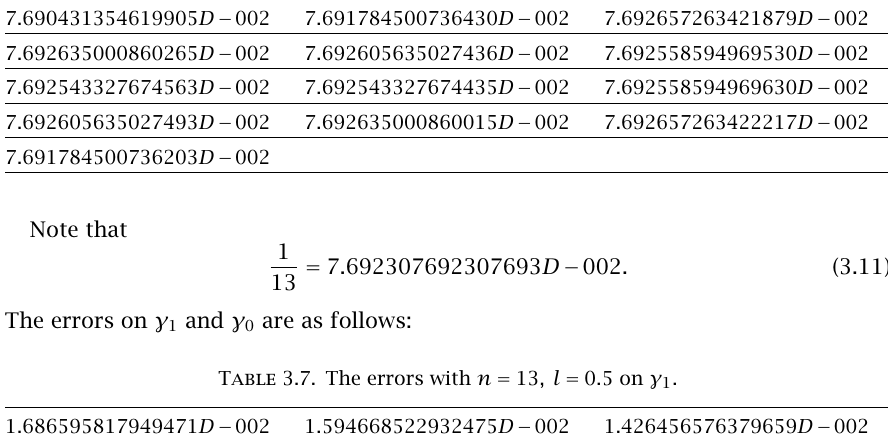
Table 3.6 . The charge distribution with n = 13 , l = 0 . 5 on γ 0 .